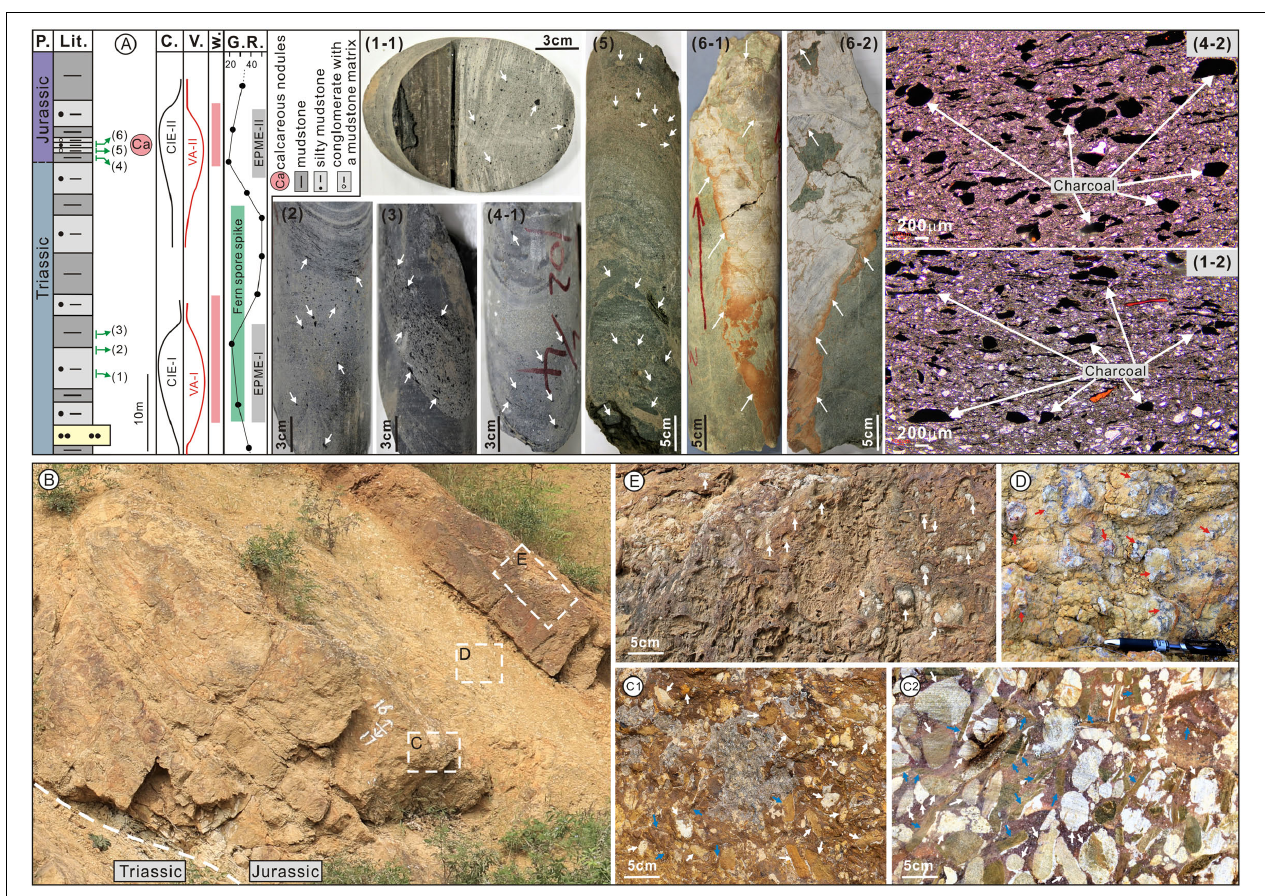
FIGURE 7 | Examples of abundant charcoal, conglomerate, mudstone clasts, and calcareous nodules from the borehole ZJ-1 and Sanhuang village section in the Jiyuan Basin during the Triassic-Jurassic transition. (A) Lithology, stratigraphic sequence, negative δ 13 C org excursions, volcanism, wildfire, and generic richness (number of difference genera) in the ZJ-1 borehole during the Triassic-Jurassic transition. Note (1-1), (2), (3), and (4-1) show abundant charcoal fossils in the middle Anyao Formation in the ZJ-1 borehole; (1-2) and (4-2) show microscopic images of charcoal fossils in the middle Anyao Formation in the ZJ-1 borehole; (5) shows mudstone clasts in the middle Anyao Formation in the ZJ-1 borehole; (6-1) and (6-2) show calcareous nodules in the middle Anyao Formation in the ZJ-1 borehole. (B) Lithology in the Sanhuang village section during the Triassic-Jurassic transition. (C1,C2 , D,E) Abundant conglomerate, mudstone clasts, and calcareous nodules from the Sanhuang village section during the Triassic-Jurassic transition. Note the white arrows represent conglomerate, blue arrows represent mudstone clasts, red arrows represent calcareous nodules. P., Period; Lit., Lithology; C., Carbon cycle; V., Volcanism; W., Wildfire; G. R., Generic richness; CIE, carbon isotope excursion; VA, interval of volcanic activity; ETME-I, first phase to the second phase of the end-Triassic mass extinction; ETME-II, second phase to the second phase of the end-Triassic mass